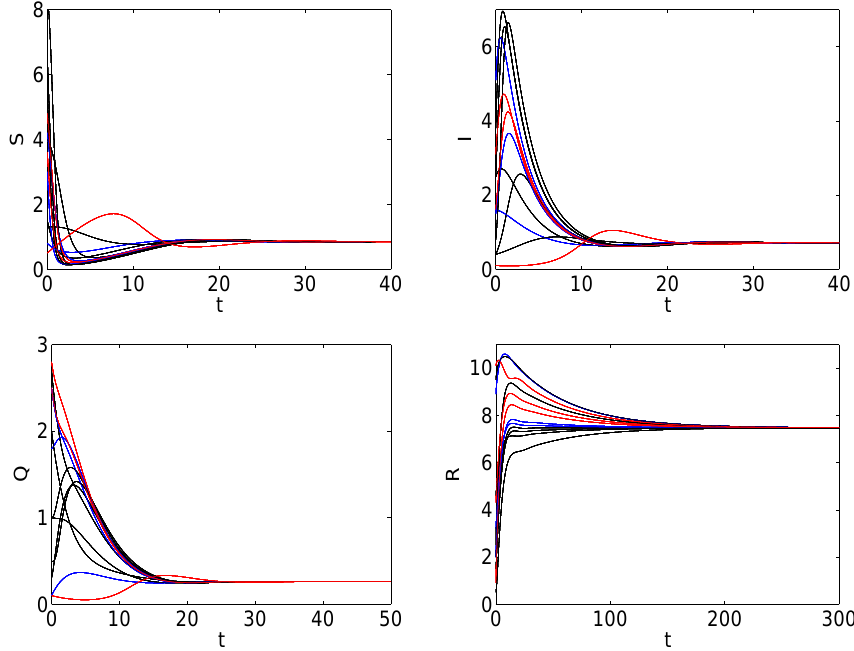
Figure 4. Variational curves of S , I , Q , and R with time t when R 2 = 11.47 > 1 for the same initial values and parameters of Figure 2 except p = q = 0.